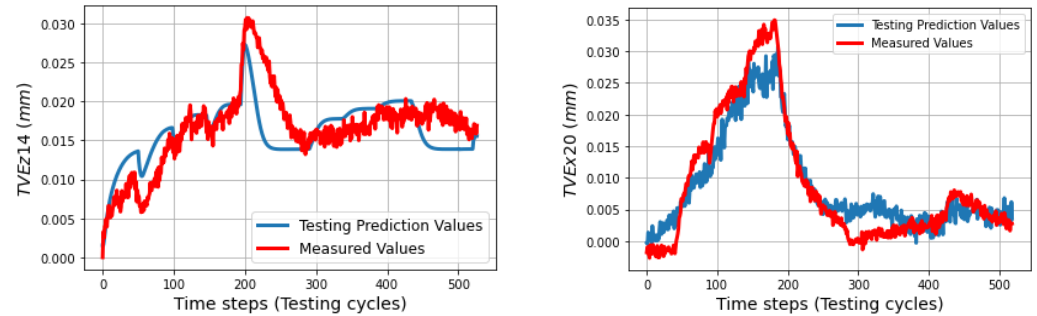
Figure 12. Prediction of TVEz14 and TVEx20 in the long process (LP) (1 cycle = 15 min) .